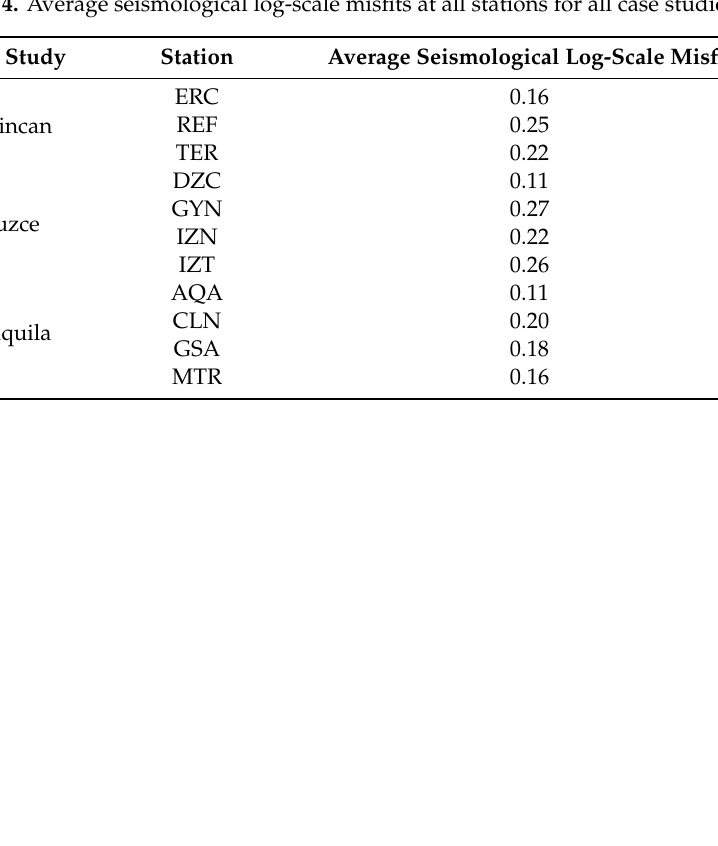
Table 4. Average seismological log-scale misfits at all stations for all case